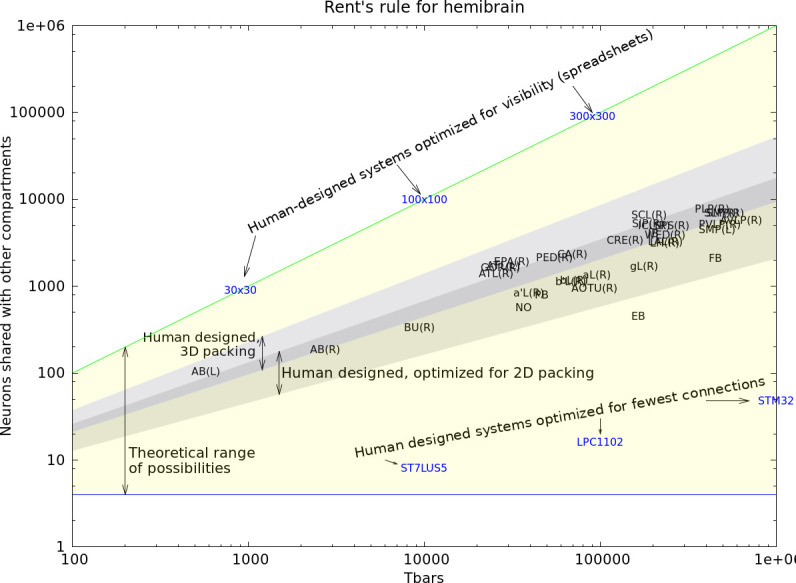
Rent’s rule for the hemibrain.The yellow region encompasses the theoretical bounds for computation. Four varieties of human-designed systems are shown. Those designed for visibility into computation achieve the upper bound, while those designed for minimum communication approach the lower bounds (Microprocessors ST7LU55, LPC1102, and STM32). Human designed systems where efficient packing is the main criterion occupy the shaded area (in 2D and 3D). The characteristics of the primary compartments completely contained in the reconstructed volume are shown with alphanumeric labels. The hemibrain compartments fall very nearly in the same range as human designed systems designed for efficient packing. Data available in Figure 26—source data 1.Figure 26—source data 1.Data for Figure 26.The first column is the compartment name, the second the number of TBars contained, and the fifth column the number of connections.